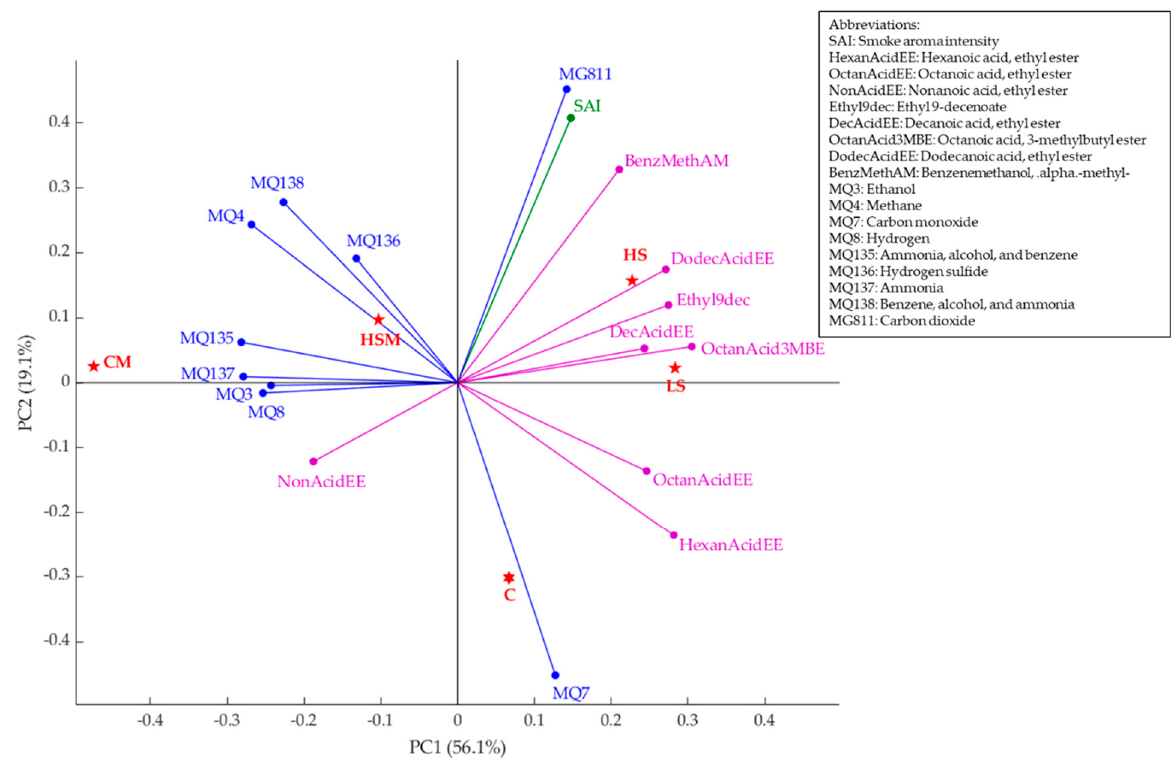
Figure 3. Principal component analysis displaying the e-nose readings (blue), smoke aroma intensity (green) and volatile aromatic compounds (purple). Abbreviations: C = control, CM = control with in-canopy misting, HS = high-density smoke exposure, HSM = high-density smoke exposure with in-canopy misting, LS = low-density smoke exposure.